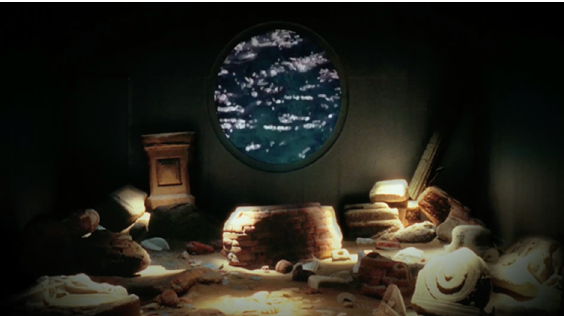
Figure 8. Eugènia Balcells, Exposure Time (still), 1989 . Multimedia installation, Sound by Peter Van Figure 8. Eug è nia Balcells, Exposure Time (still), 1989. Multimedia installation, Sound by Peter Van Riper . Photo: Copyright 1989, Eugènia Balcells Foundation, published with permission. Riper. Photo: Copyright 1989, Eug è nia Balcells Foundation, published with